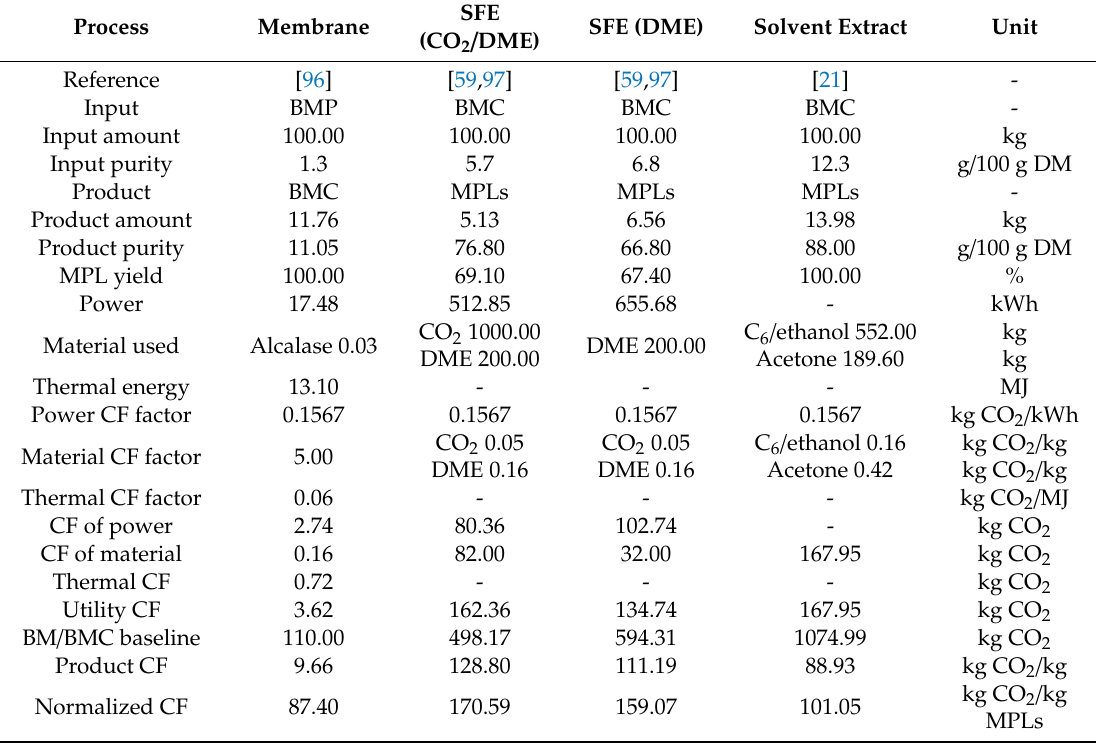
Table 4. Normalized carbon footprints of milk phospholipids (kg CO 2 / kg